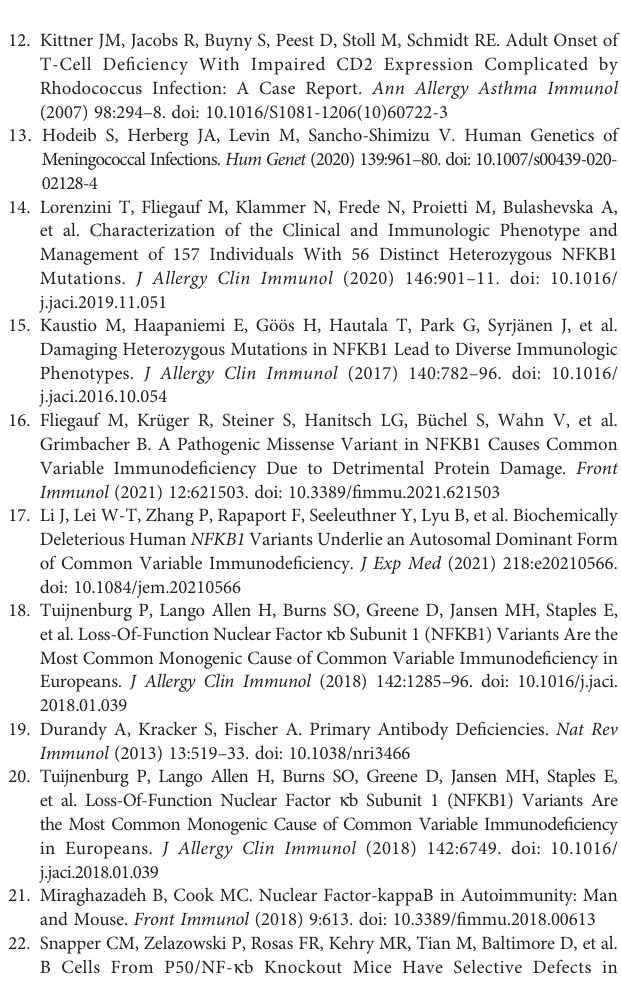
PCRshowedareductioninthetranscriptlevelsofp105inthemutantcomparedtothe wild type. Delta delta Ct was then determined by subtracting D Ct (variant) from D Ct (wild type). Fold change in expression was calculated using 2- DD Ct. Supplementary Figure 2 | Densitometry analysis. Densitometry analysis was performed for p105 and p50 expression in the transfected HEK293 cells and PBMCs. (A) Expression of p105 in HEK293 cells transfected with wild type NF k B1 and mutant (p.R230C). (B) Expression of p50 in HEK293 cells transfected with wild type NF k B1 and mutant (p.R230C) showed a reduction in the p50 by immunoblotting. Both p105 and p50 were drastically reduced in the mutant compared to the wild type. (C) Expression of p105/50 in the PBMCs of healthy control (HC) and mutation carriers (S1-S3). Densitometry analysis revealed lowered expression in all subjects compared to the control. (D) PBMCs from HC and S1, S2 and S3 were stimulated with PMA; 50 ng/ml and ionomycin;1 m g/ml and the expression of p105/50 examined. There was no signi fi cant changes in the p105/50 expression after